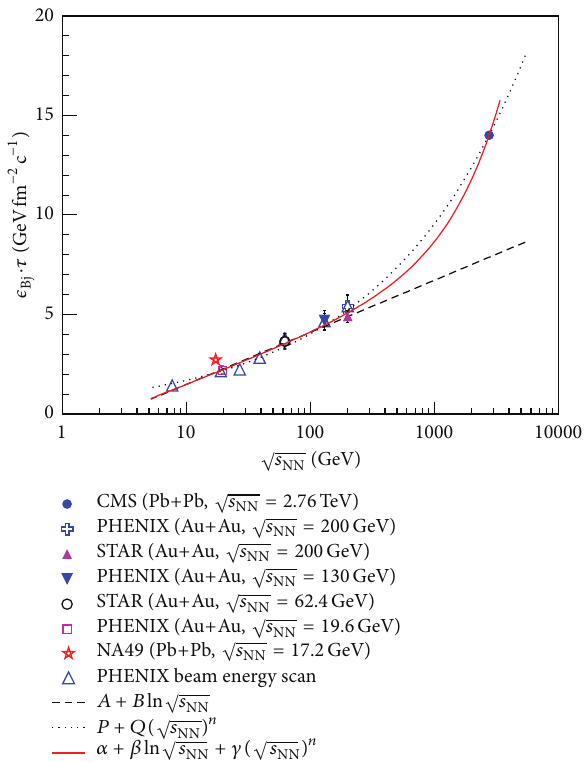
⋅ 𝜏 [GeVfm −2 c −1 ]. Loga- Figure 41: The excitation function of 𝜖 Bj rithmic prediction fails to explain the LHC data. Shown are different phenomenological data driven fitting functions to describe the observable as a function of collision energy.